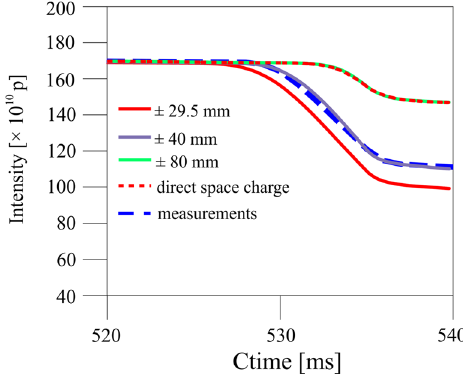
FIG. 24. Dynamic integer with COD correction: simulations with different chamber heights.